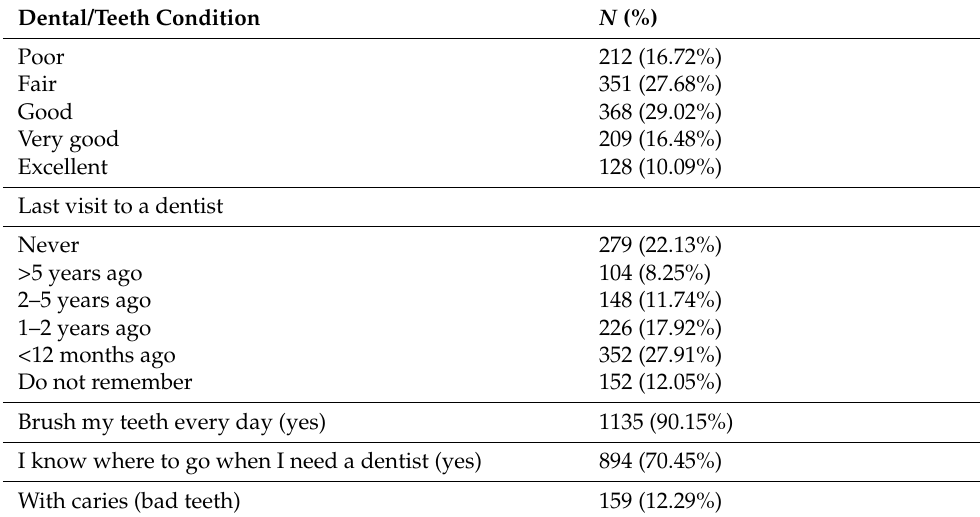
Table 2. Dental health and screening frequency of migrants and refugees, except those from Germany, France and Malta ( N =